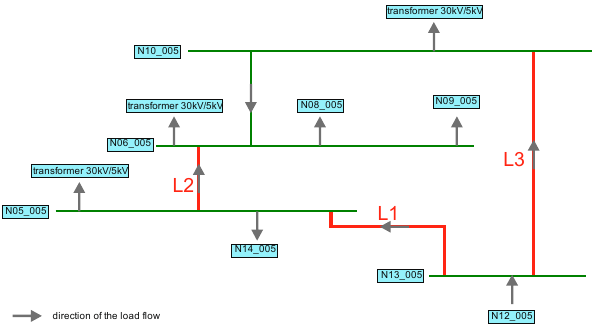
Figure 19. Schematic grid section - illustration of the direction of load flows for a penetration of 60% PV and 100% EV, 3.7 kW charging power and charging strategy 1 for the time of maximum utilisation of line 1.